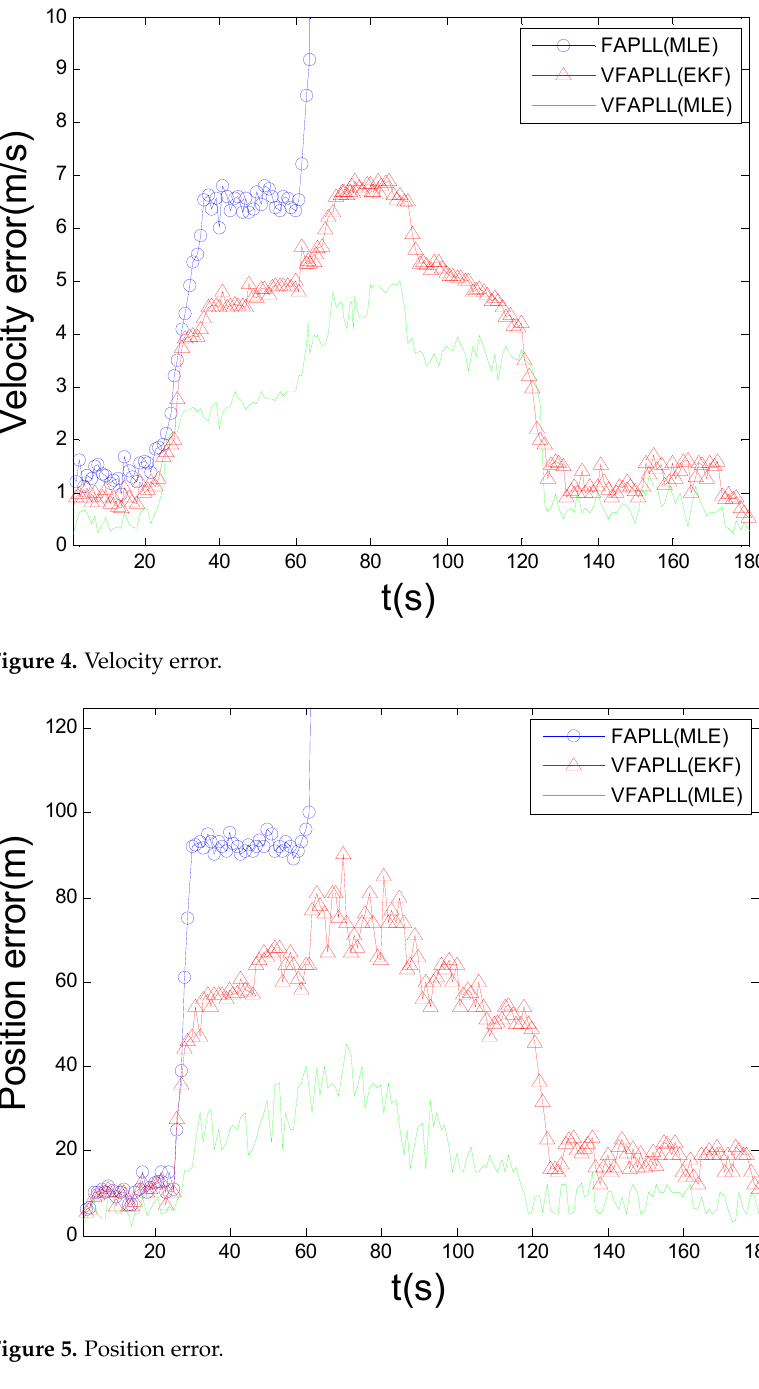
Figure 5. Position Figure 5. Position error. Figure 5. Position error.